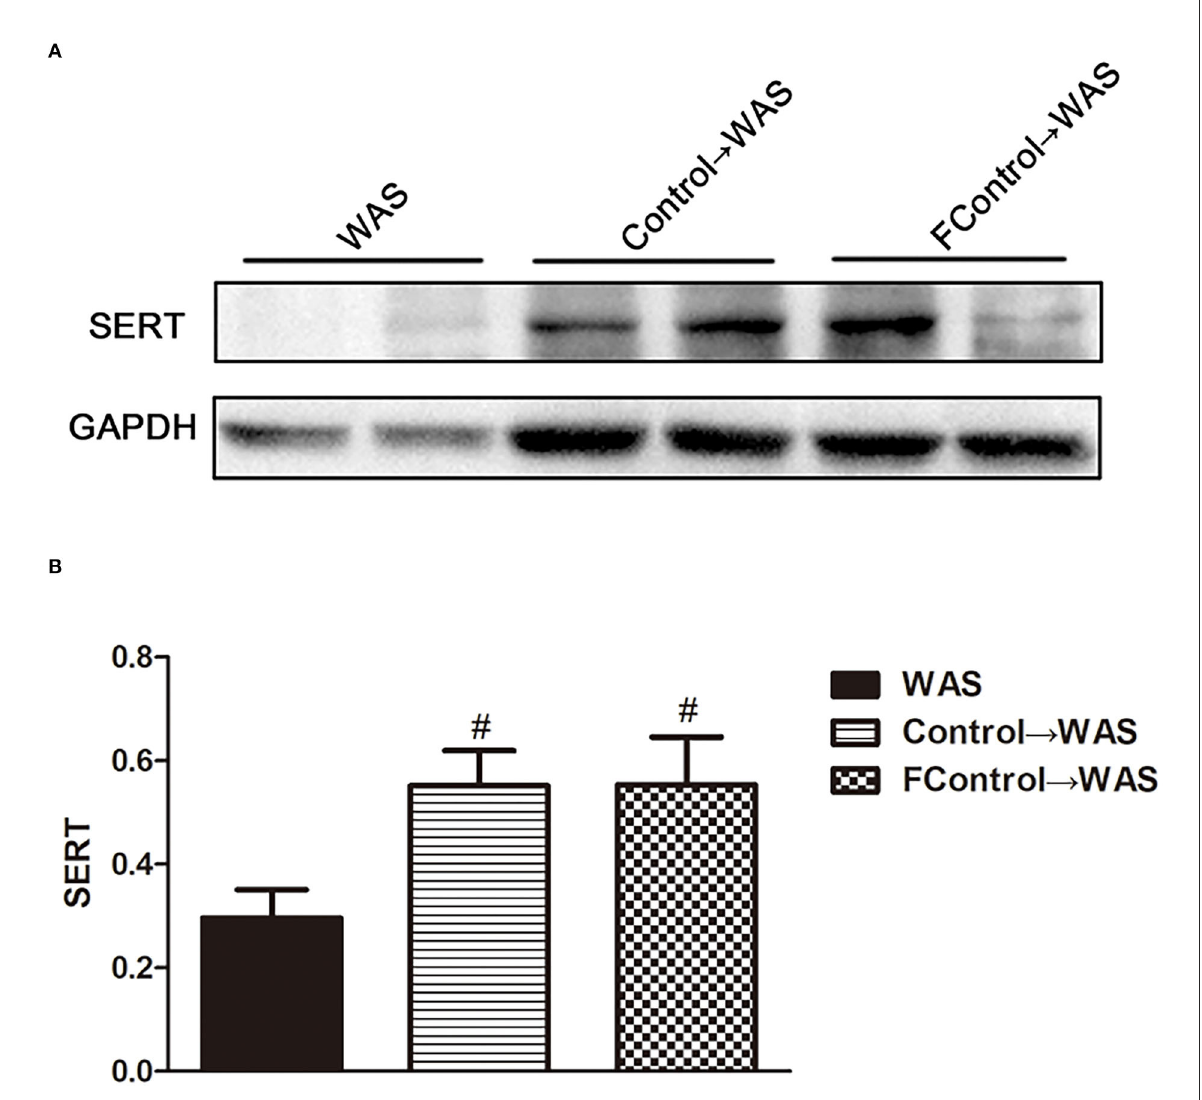
FIGURE8 Effect of filtered FML on SERT expression in the colon of rats. (A) SERT protein expression plot in the colon. (B) Statistical plot of SERT protein expression in the colon (All results are expressed as mean ± SE n = 3/group, # P < 0.05 vs.